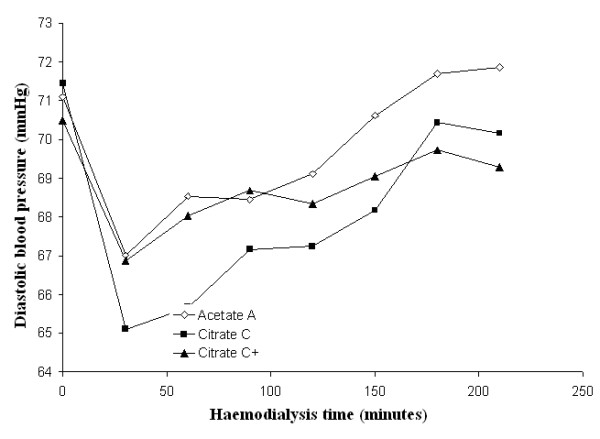
Diastolic blood pressure. Diastolic blood pressure as a function of the haemodialysis time using, respectively, acetate (A) (empty diamonds), calcium uncorrected citrate (C) (black squares) and calcium supplemented citrate dialysate (C+) (black triangles).